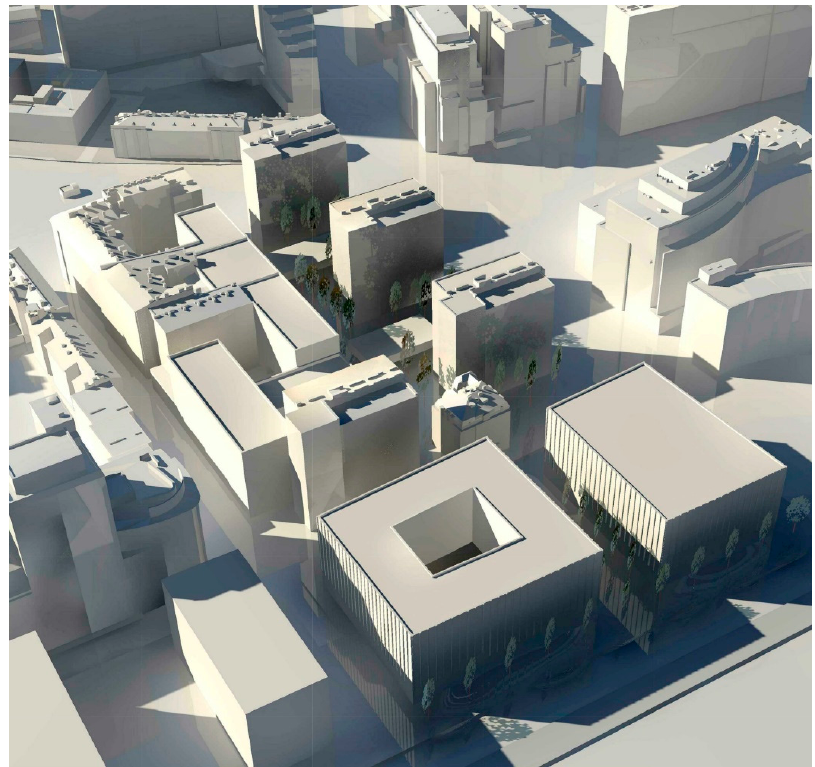
Figure 2. Proposed site development—Visualisation. Building under analysis is the first on the right.